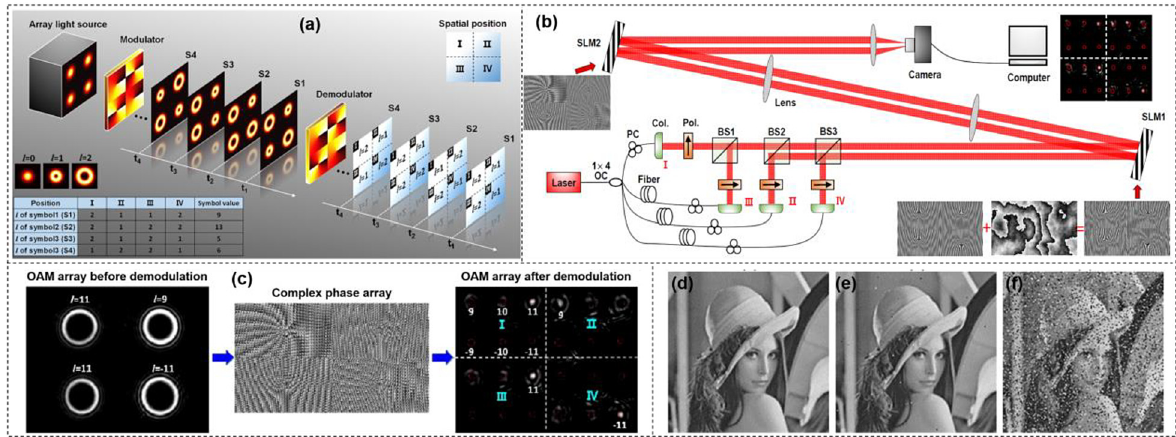
Figure 7: OAM array modulation communications.